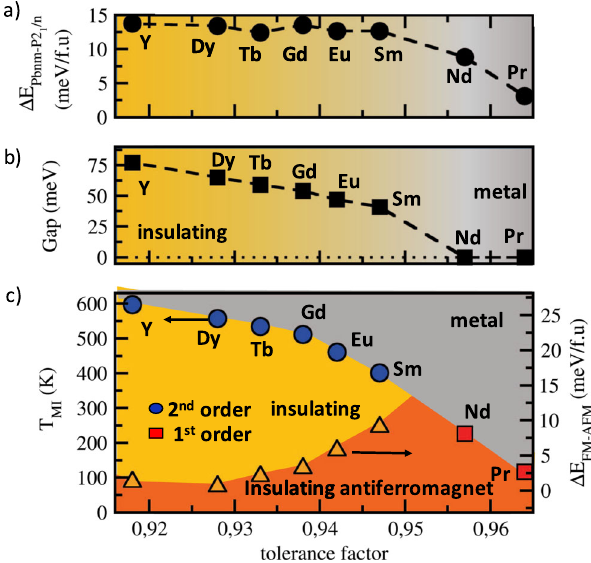
Fig. 5 Metal – insulator phase transition a Energy difference in meV per formula unit between the relaxed monoclinic and orthorhombic phases for a FM solution. b Band gap (in meV) of the FM monoclinic phase. c Left scale : phase diagram of rare-earth nickelates established on the basis of our fi rst-principles calculations. Blue- fi lled circles and red- fi lled squares correspond to second order ( T T N ) and fi rst order ( T MI = T N ) metal – insulator phase transitions, respectively. Right scale : energy difference in meV per formula unit between the monoclinic FM and AFM solutions for R = Y to